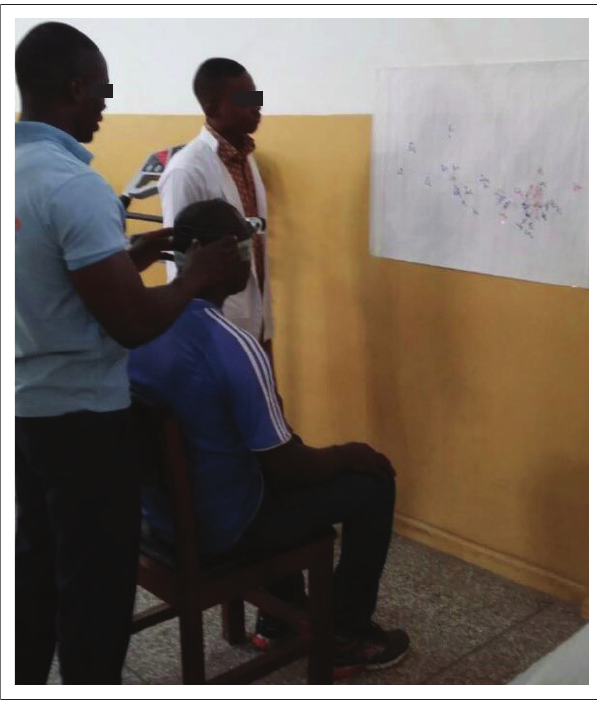
FIGURE 1: Participant seated wearing a headlight laser pointer on the head.